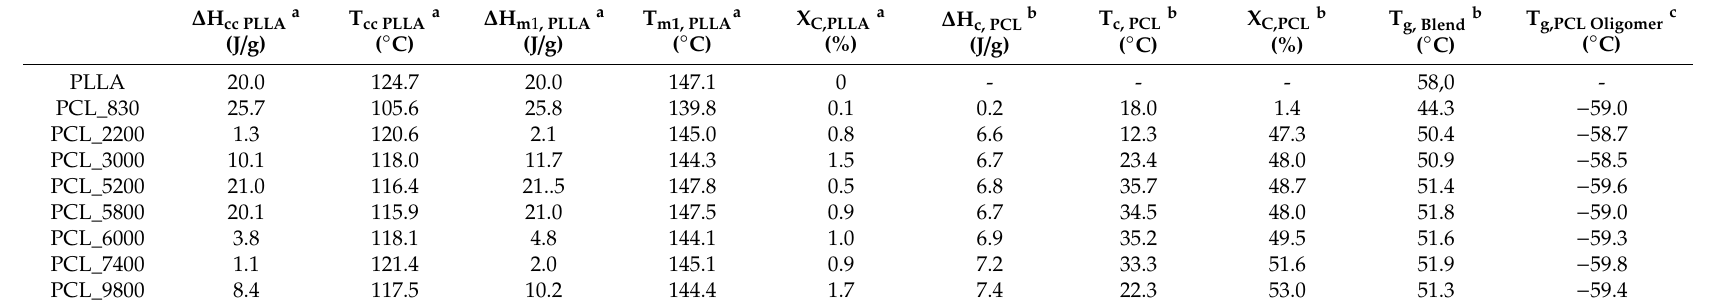
Table 2. Thermal properties of blends of PLLA containing 10 w% of PCL oligomers of di ff erent chain